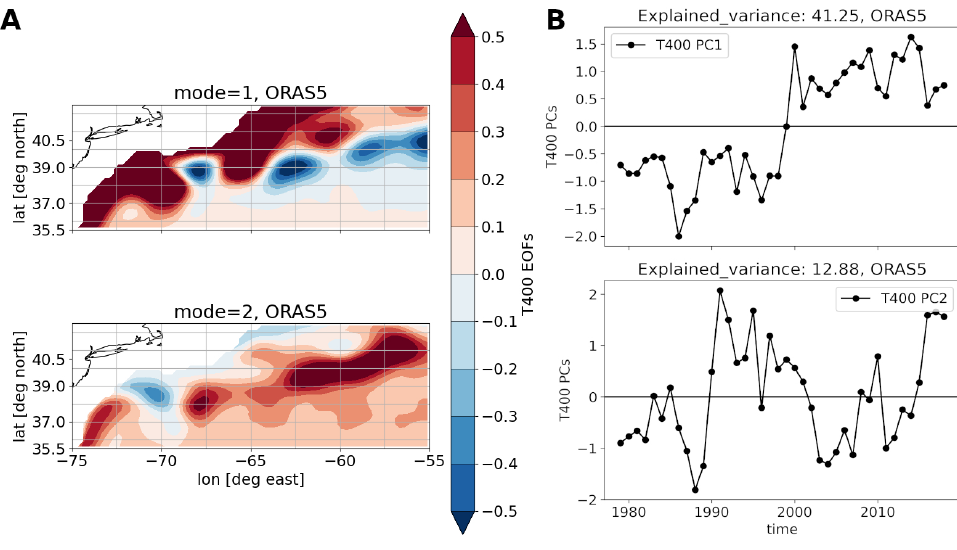
Figure 4. ( A ) EOFs of the temperature field at 400 m (T400). ( B ) Corresponding PCs from ORAS5 data. The Gulf Stream index is the first mode in the